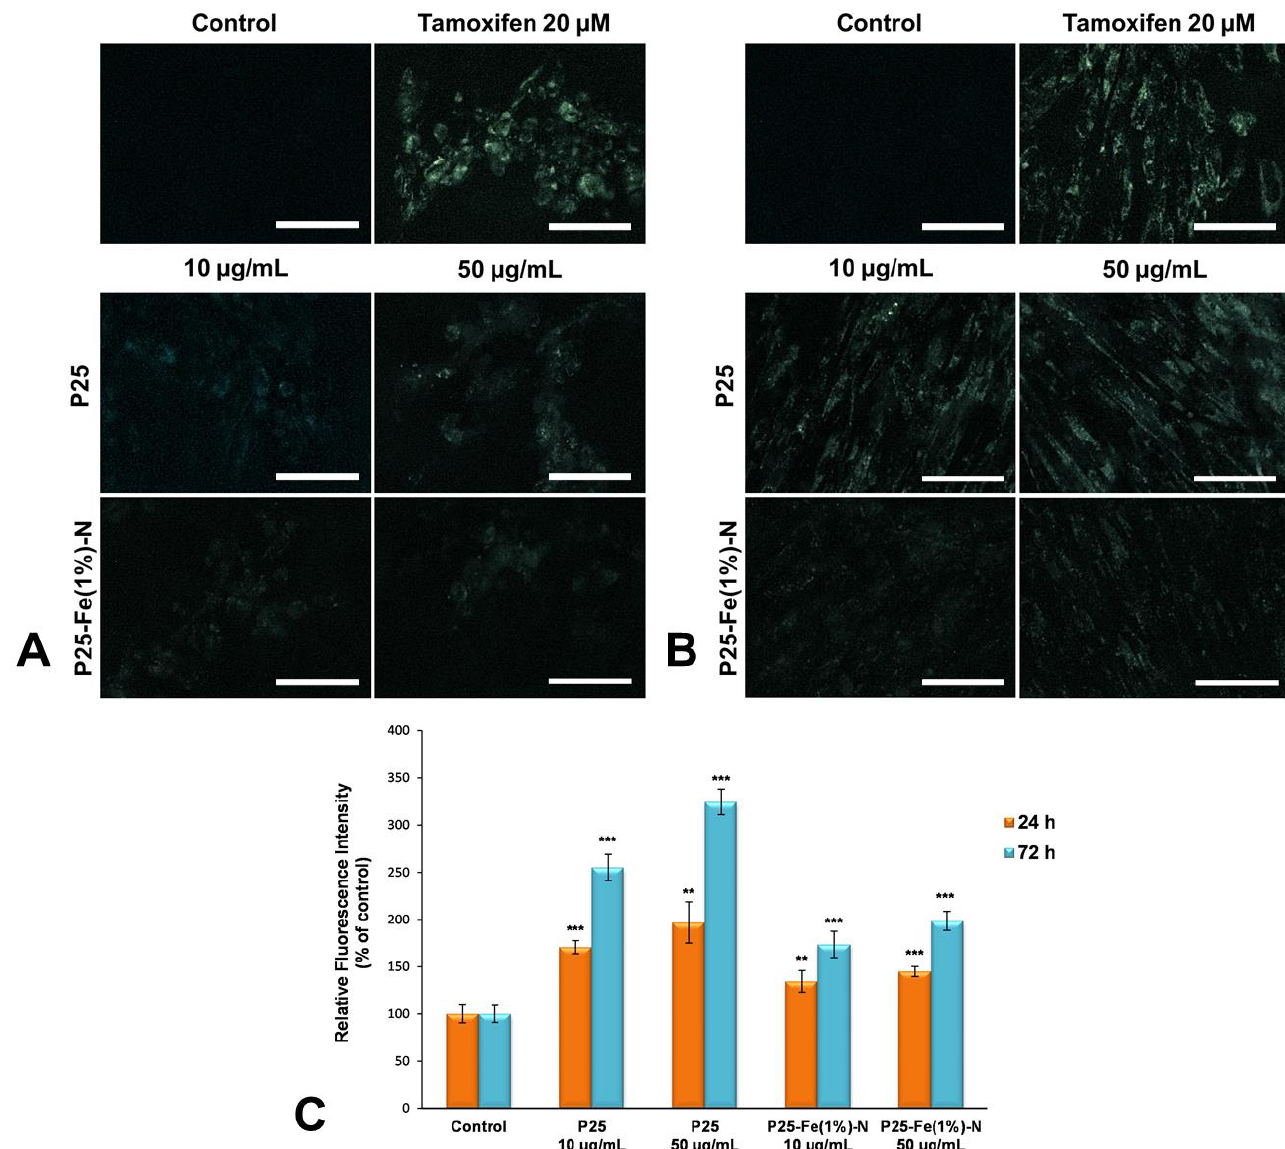
Figure 7. Autophagy induced in MRC-5 cells by TiO 2 NPs. Representative images of fluorescence microscopy showing the autophagic vacuoles induced in normal lung fibroblasts after exposure to different concentrations (10 and 50 μg/mL) of the two TiO 2 NPs samples: P25 Degussa and P25-Fe(1%)-N for 24 ( A ) and 72 h ( B ). Scale bar: 100 µm; ( C ) Quantification of MDC fluorescence intensity by Image J software (National Institutes of Health, Bethesda, MD, USA); Results are expressed as means ± standard deviation (SD) ( n = 3) and represented relative to the untreated cells (control). ** p < 0.01 and *** p < 0.001 compared to control.